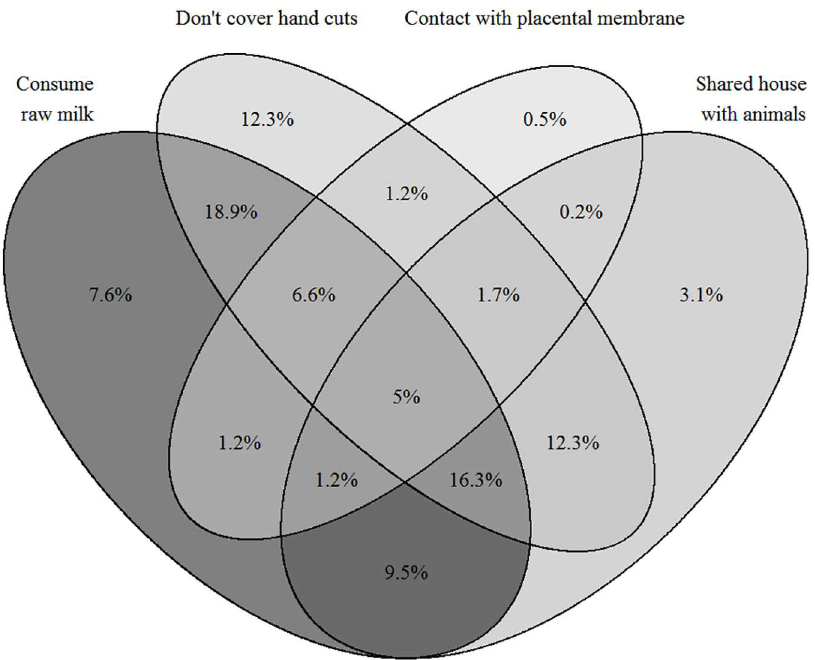
Fig 3. Venn diagram showing the percentages of smallholder dairy farmersin Pakistan having combinations of multiple household practices posing a risk of brucellosis transmission from animals to human.